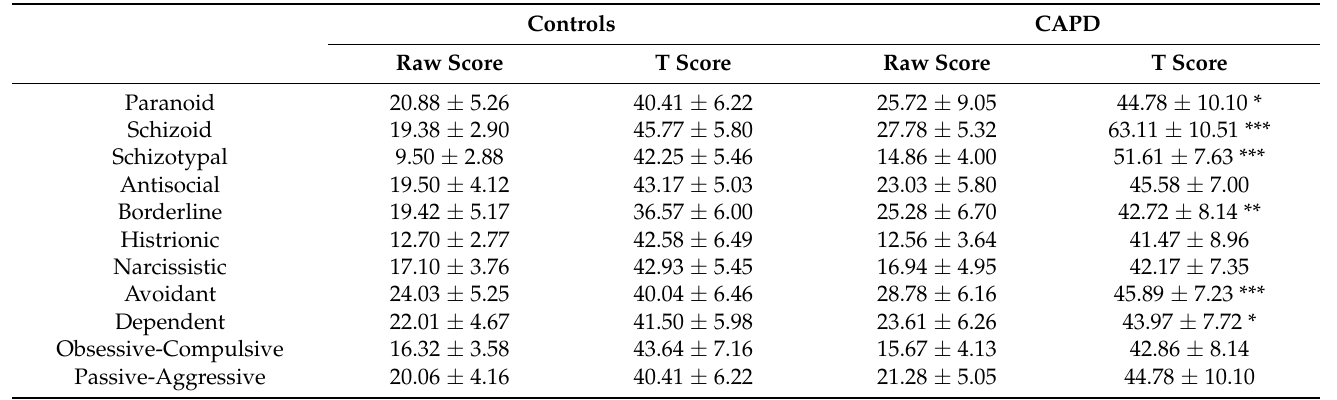
Table 2. Mean raw and T scores (mean ± S.D) of the Parker Personality Measure in healthy volunteers (controls, n = 115) and cluster A personality disorders (CAPD, n = 36).